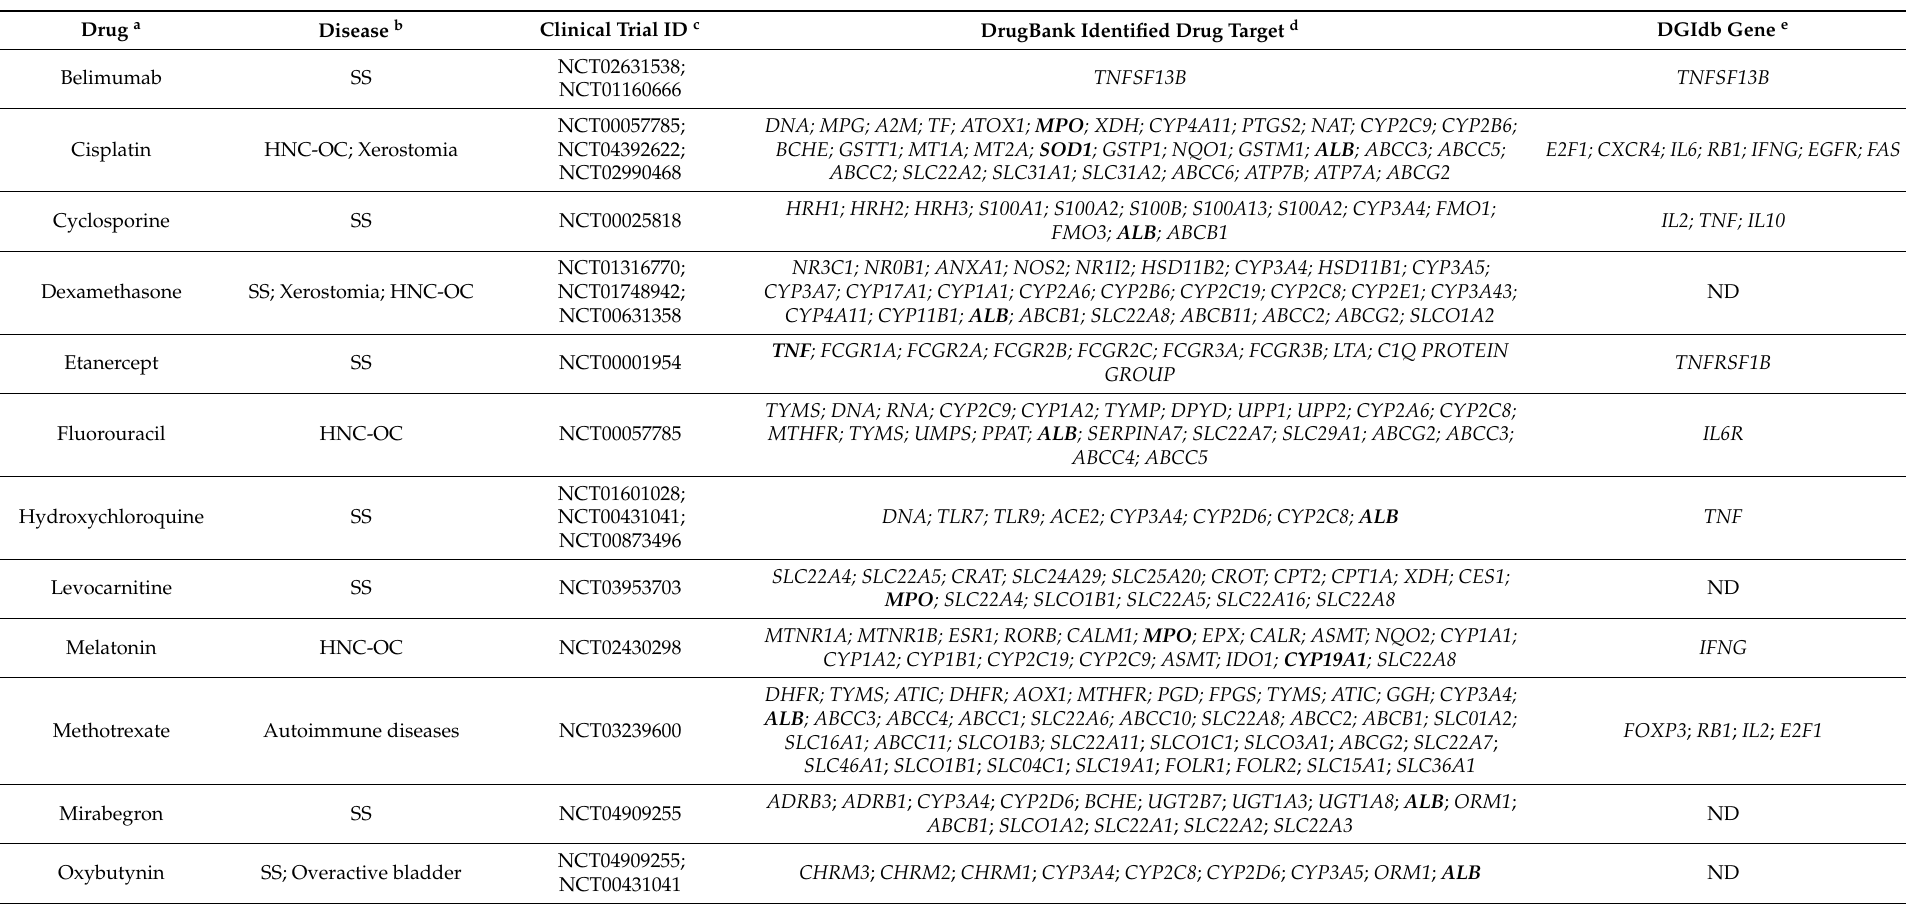
Table 2. Drugs Evaluated via ClinicalTrials.gov and the Drug–Gene Interaction Database Identified Drug–Gene Interactions. a Drug identified by Clinicaltrials.gov (https://ClinicalTrials.gov/) that has been/is being evaluated for diseases related to xerostomia/dry mouth. b Disease that the drug has been/is being evaluated for with an input search in ClinicalTrials.gov of “xerostomia” and “dry mouth”. c ClinicalTrials.gov identifier. d Gene targets of drug identified using DrugBank (https://go.drugbank.com). Genes shown in bold are in common with the 54 genes identified with interactions using the Drug–Gene Interaction database (DGIdb) (https://www.dgidb.org/). e Genes identified by DGIdb (https://www.dgidb.org/) as having interactions with the drug. Note: HNC-OC is head and neck cancer oral complications; ND is not determined; SS is Sjögren’s